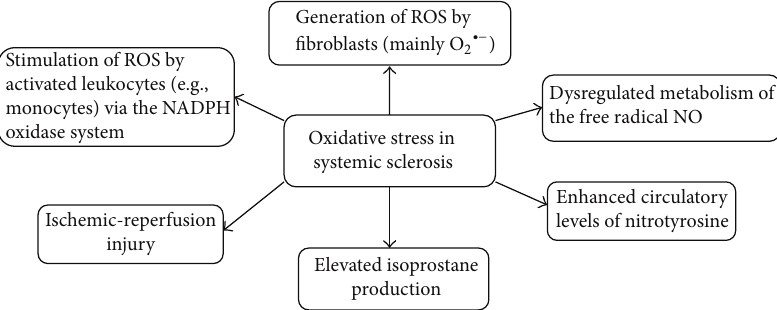
Figure 1: The main mechanisms of oxidative stress in systemic sclerosis. NADPH oxidase: nicotinamide adenine dinucleotide phosphate- oxidase; oxLDL: oxidized low-density lipoprotein; ROS: reactive oxygen species; O 2∙− : superoxide